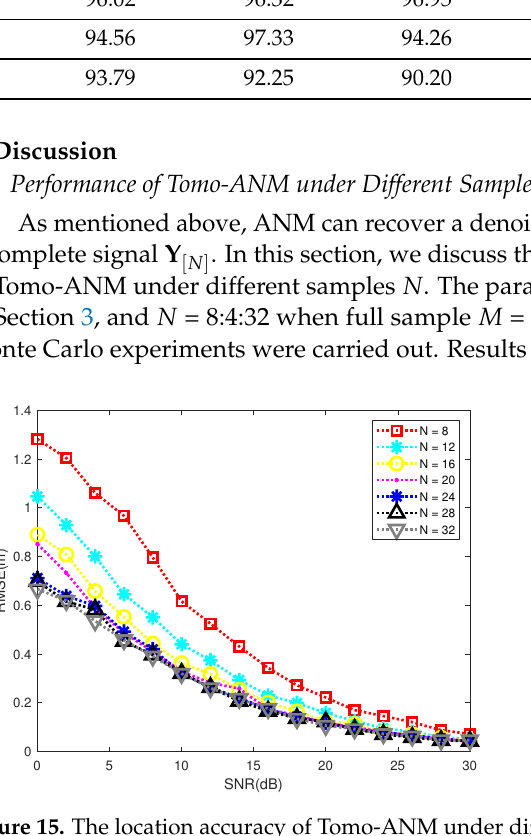
Figure 15. The location accuracy of Tomo-ANM under different samples N and SNRs.